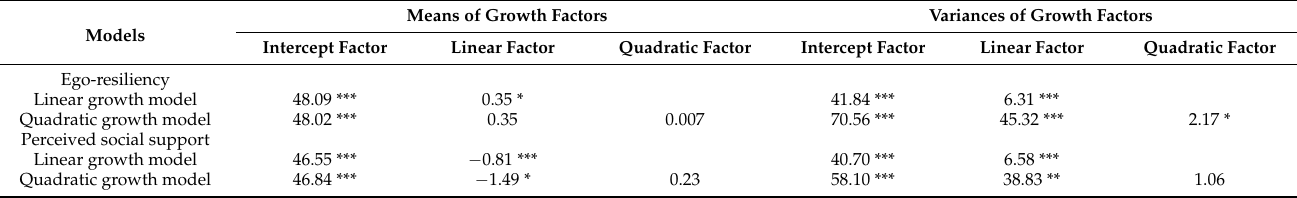
Table 3. Parameter Estimates of Latent Growth Models for Ego-Resiliency and Perceived Social Support.